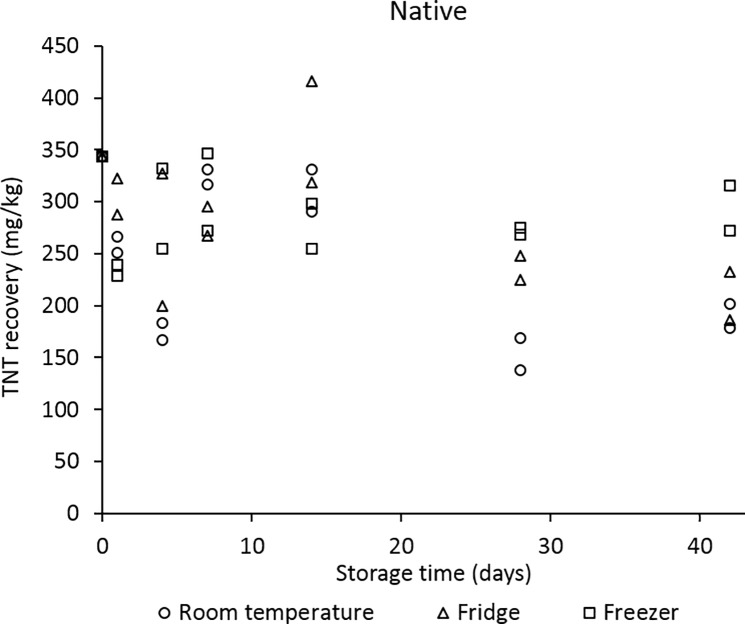
TNT recoveries obtained from post-blast native soil samples stored at 3 temperatures, extracting over 6 weeks.